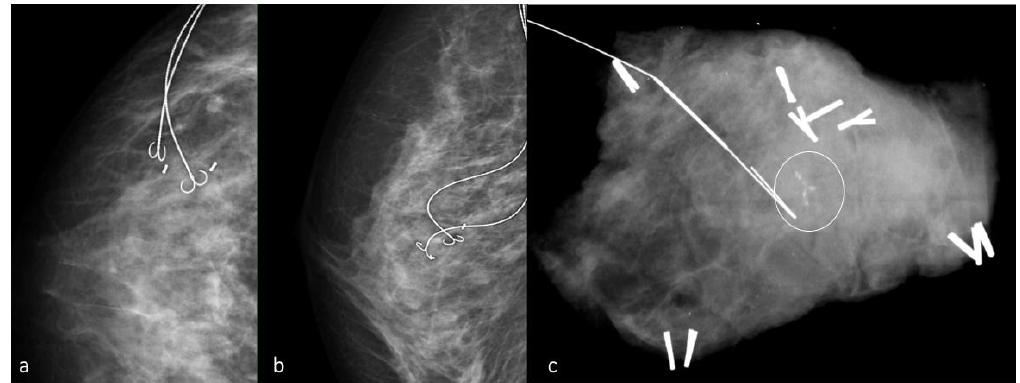
Figure 1. Wire-guided localization. Craniocaudal ( a ) and mediolateral ( b ) oblique mammograms taken after hookwires insertion show optimal wires positioning, with the wires at the biopsy markers site. A specimen radiograph ( c ) contains the hookwire and the residual calcifications (circle).